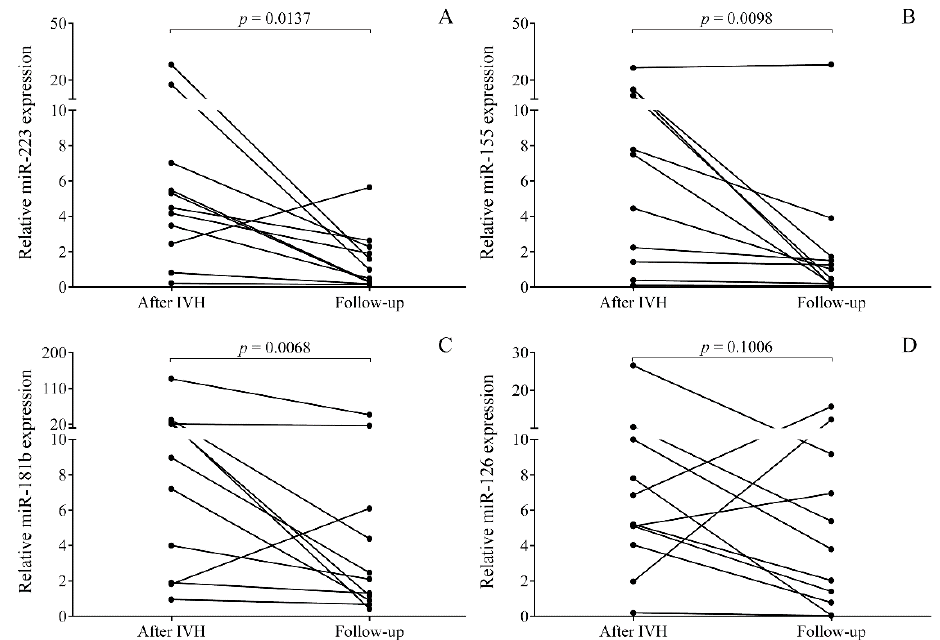
Figure 4. In those IVH patients ( n = 11) with whom follow-up specimens were available, a positive correlation was observed between the change in oxidized Hb forms and miRNAs over time. In these patients, oxidized Hb content was not detectable by the end of follow-up period. IVH-induced elevation of miR-223, miR-155, and miR-181b was diminished ( A – C ) during the follow-up phase, while miR-126 did not show significant alteration ( D ). Dots represent single expression values of the pairs. Wilcoxon matched-pairs sign rank test or paired t-test was performed for the comparison. Hb: Hemoglobin, IVH: Intraventricular hemorrhage, miRNA: MicroRNA.